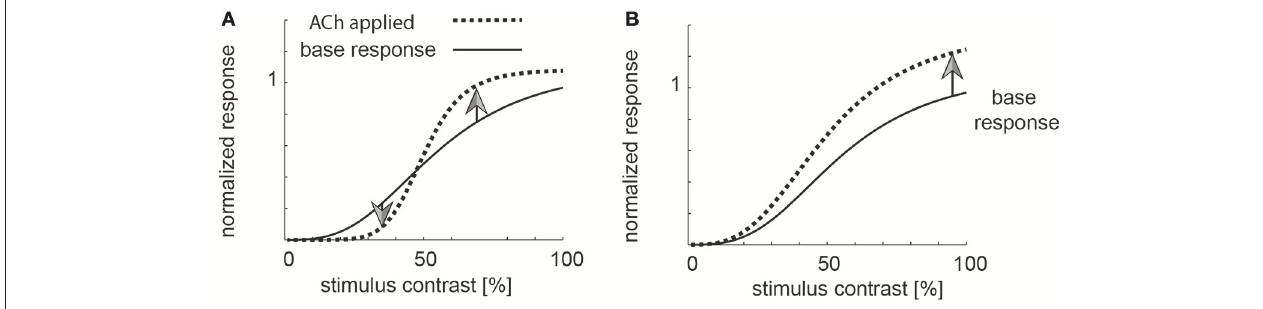
FIGURE 1 | Potential role of cholinergic neuromodulation. (A) If acetylcholine was involved in a form a saliency enhancement, the prediction would be that weak stimuli (low contrast) are suppressed by high levels of acetylcholine, while strong stimuli would be enhanced. (B) If acetylcholine was involved in sensitivity enhancement, then all stimuli (weak and strong) would be processed more